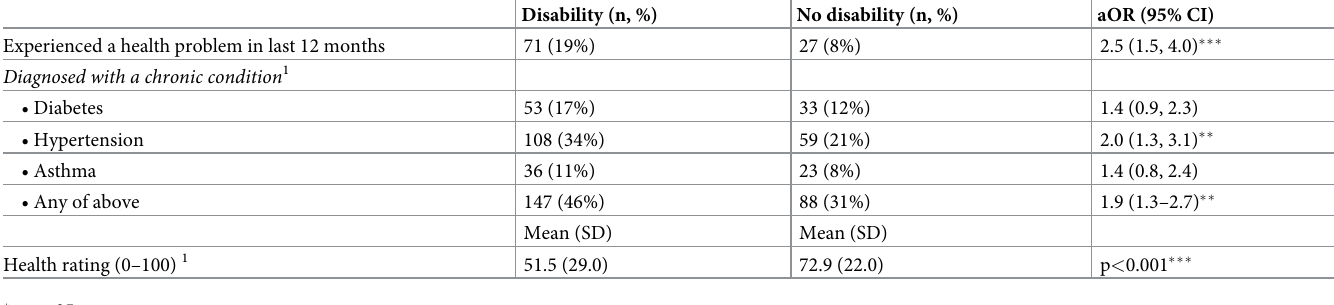
Table 2. Health status amongst people with and without